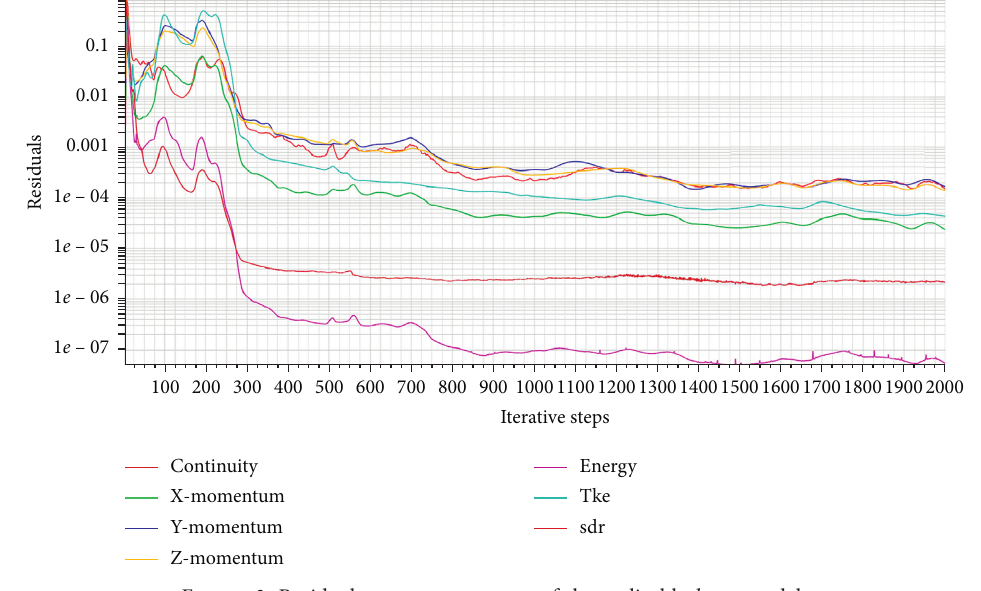
Figure 3: Residual convergence curve of the realizable k − ε model.